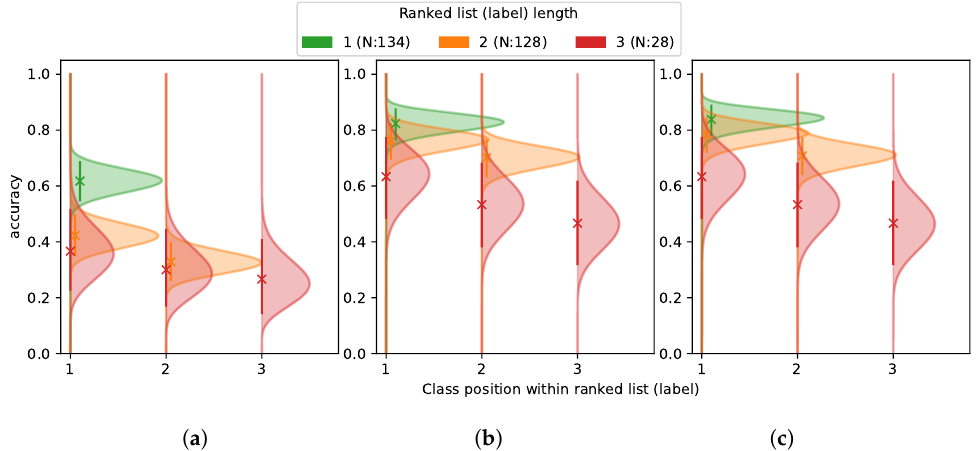
Figure 8. The Accuracy of labels compared to pseudo ground truth (best optical labels) for label length (green, orange, and red) and class position within the label (X-axis). Three different class groupings are explored: ( a ) individual UXO types; ( b ) shells, bombs, debris, and natural; ( c ) dangerous and harmless. Accuracy is calculated as a beta distribution from a Bernoulli likelihood (“N” successes and failures) with beta (1,1) uninformative